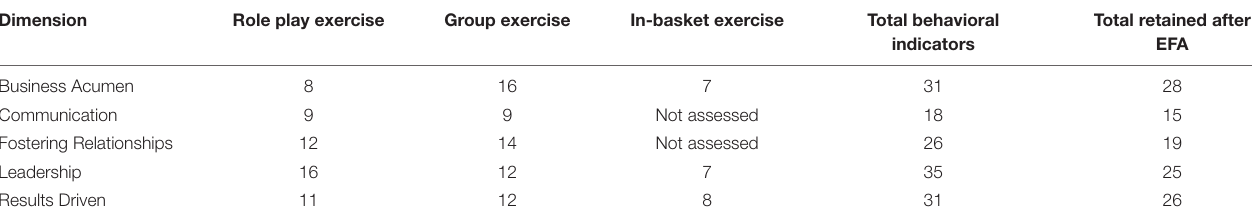
TABLE A1 | Number of behavioral indicators measured in each AC exercise and retained after EFA for further analysis for Model 1. Dimension Role play exercise Group